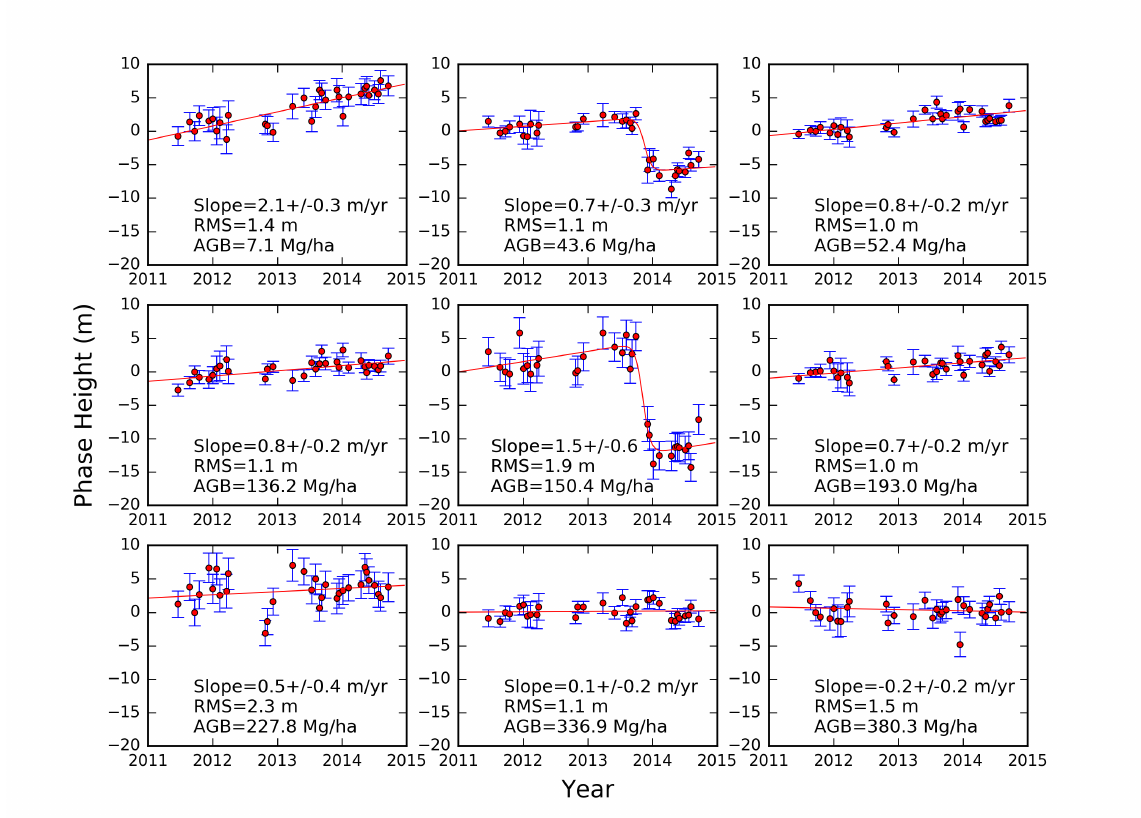
Figure 5. Phase-height versus time in years for 9 of 78 plots. All heights are differences relative to 22 September 2011. Red lines are linear fits of phase-height to time for plots without a jump. “Slope" is the fit linear rate. The number after the sign is the formal error on the slope. Plots with mass ± < 250 Mg-ha − 1 tend to have more positive rates than those with AGB > 250 Mg-ha − 1 . Two plots with jumps, due to agricultural clearing are in panels 2 and 5. The red line for those plots is the logistic function. For those plots, “slope" is a single rate estimated with the logistic function applied before and after the jump. The AGB (before clearing for jump plots) is also shown, and the RMS about the fit function is also